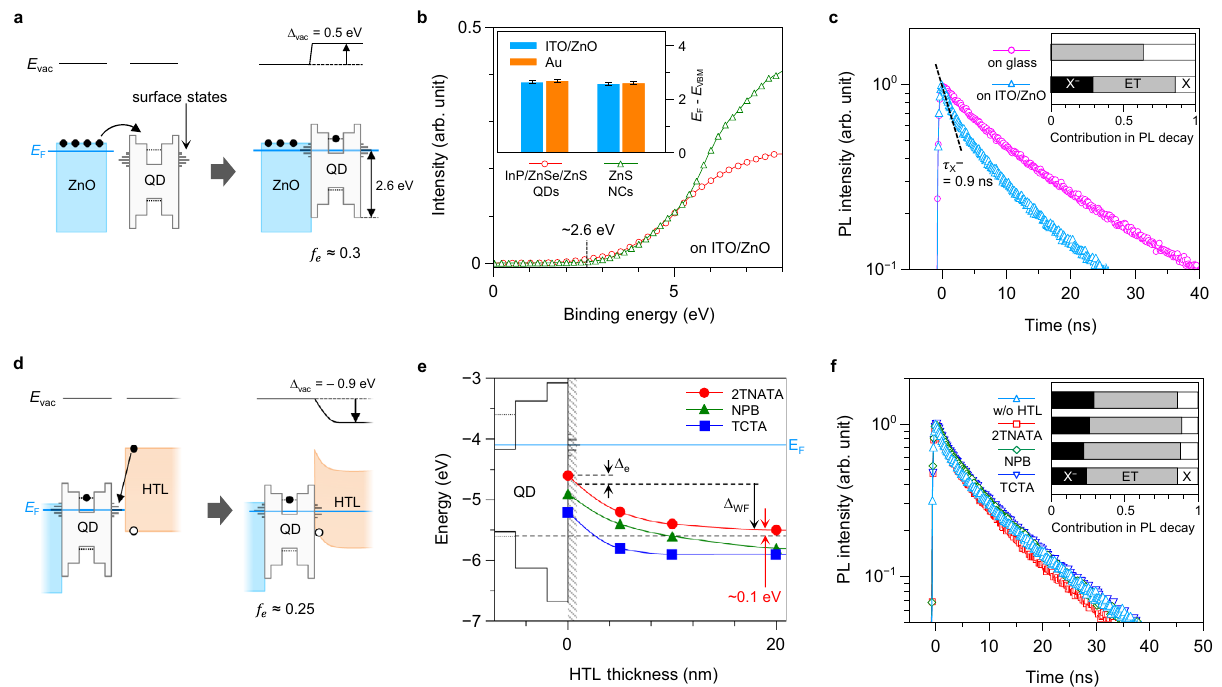
Fig. 2 Interfacial electrostatic potential gain by surface state-derived Fermi level alignment. a Modi fi cation of energy levels at a ZnO ETL – QD EML junction. Blue solid line represents Fermi level ( E F ). Vacuum level shift ( Δ vac ) is estimated to be 0.5 eV. b UPS spectra of InP/ZnSe/ZnS QDs (red square) and ZnS NCs (green triangle) on ITO/ZnO substrates at low binding energy region. Inset shows the E F − E VBM values on ITO/ZnO (blue) and Au (orange) substrates. Error bars indicate an instrument resolution, 0.05 eV. c PL decay dynamics of QDs on glass (pink circle) and ITO/ZnO substrates (sky blue triangle). X − decay occurs at an early stage in the case of ITO/ZnO, with a negative trion lifetime τ X (cid:1) = 0.9 ns. Inset displays fractions of decay channels: X − (black), neutral exciton (X, white), and delayed recombination by energy transfer (ET, grey). d Band bending at the QD – HTL junction with Δ = − 0.9 eV. e HOMO levels of 2TNATA (red circle), NPB (green triangle), and TCTA (blue square) on ITO/ZnO/QDs substrates as a function of HTL vac thickness. f PL decays of QDs in ITO/ZnO/QDs/HTLs: without HTLs (sky blue triangle), 2TNATA (red square), NPB (green diamond), and TCTA (blue inverse triangle). Inset shows the contribution of X − (black), X (white), and ET (grey). All PL decays were acquired at the entire emission range with excitation at 488